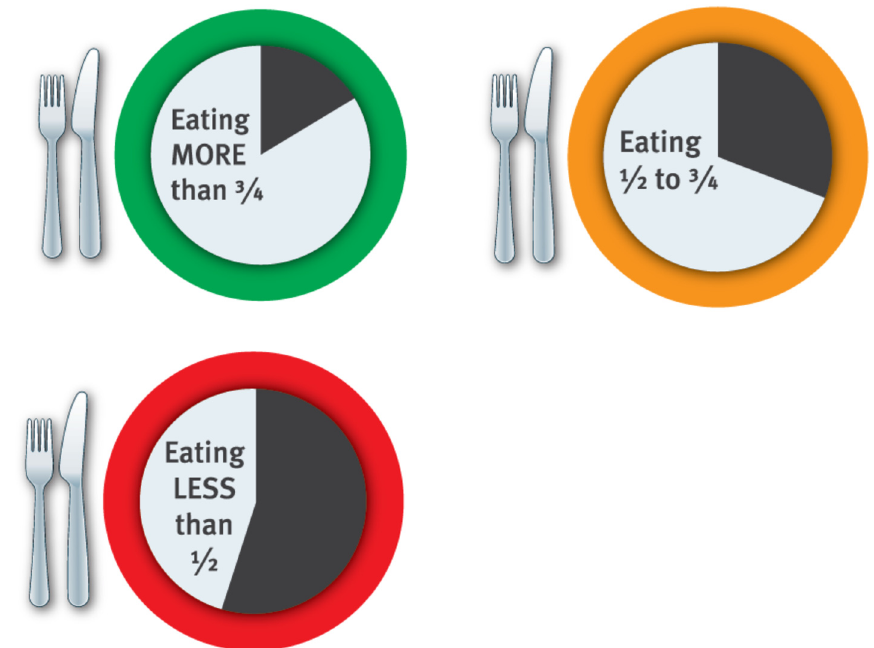
Figure 2. Patient nutrition intake whiteboard magnets.